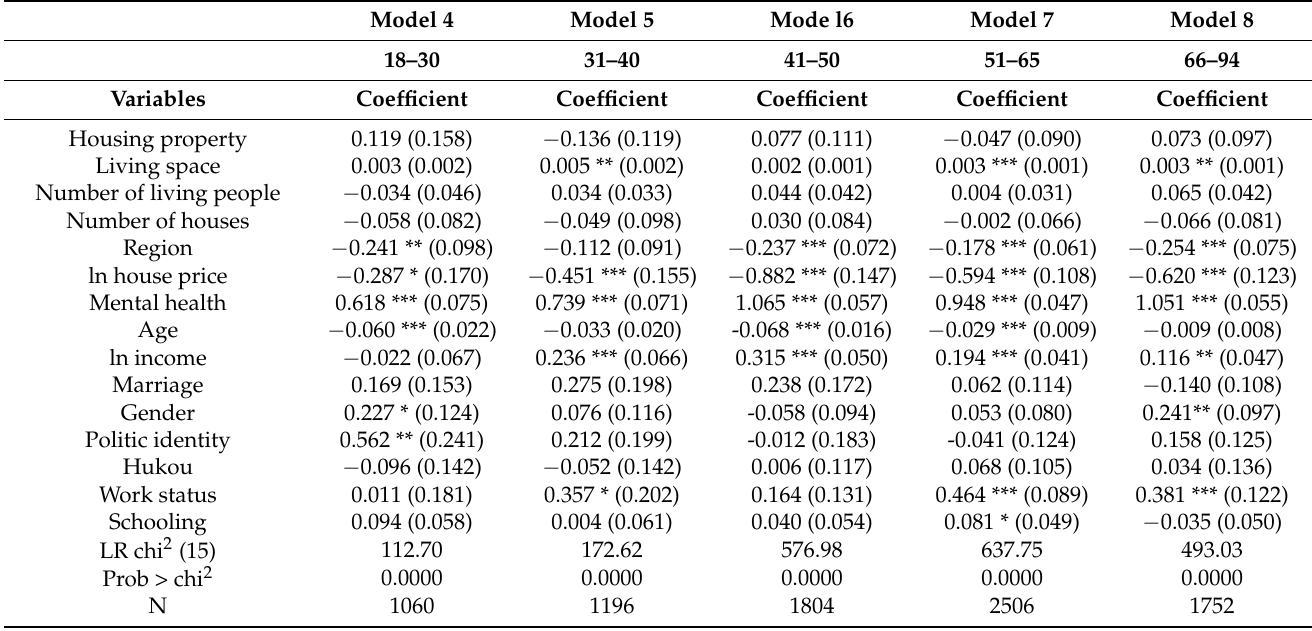
Table 5. Results for the impact of housing on self-rated health by age group.